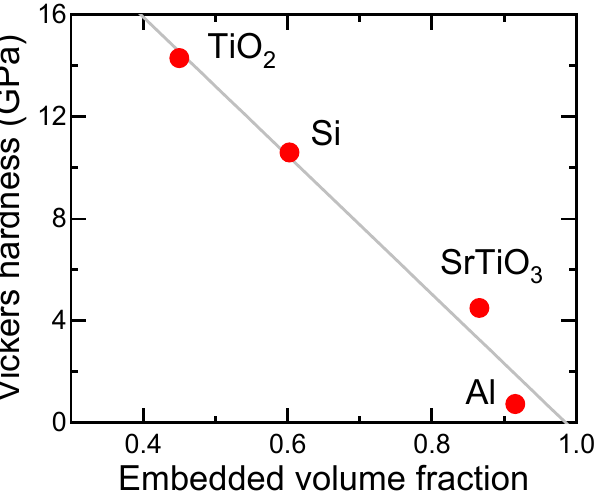
Figure 16. Relationship between Vickers hardness of substrates and average embedded volume fraction of SMPs.